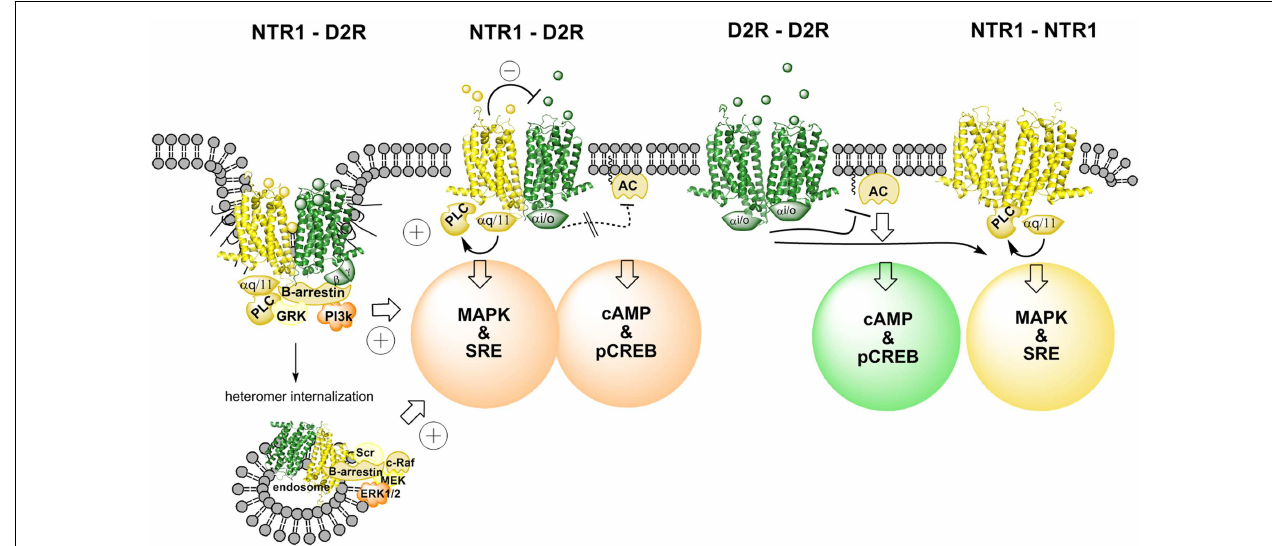
signaling pathway at the level of PKC.Thus, the NTR1 agonist can activate the NTR1 protomer, which activates the MAPK–SRE pathway via Gq/11–PLC–PKC.The D2R agonist can target the D2R protomer and produce its activation of the MAPK–SRE pathway via several